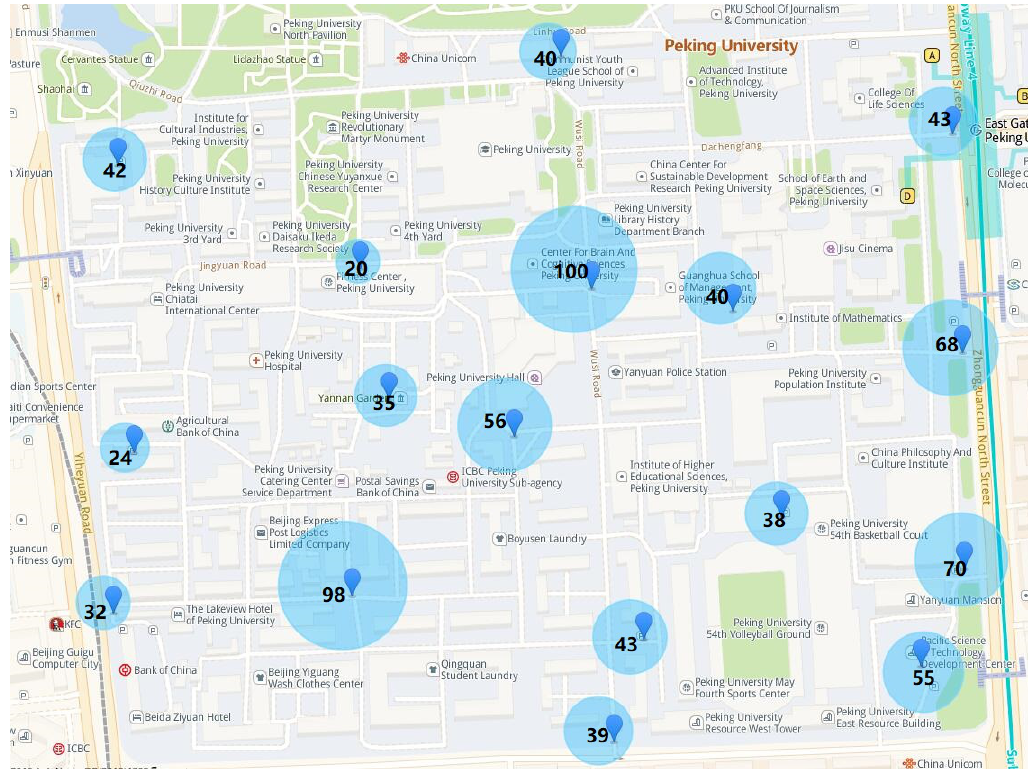
Figure 6. Analysis of Traffic Travel